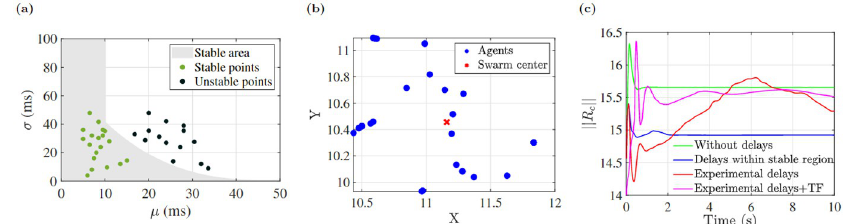
Fig 10. (a) Gaussian stability area for different mean and standard deviation (gray color indicates stable area, green and black points represent stable and unstable regions respectively), (b) experimental delays show unstable behavior, (c) norm of swarm center || R || for different cases. c